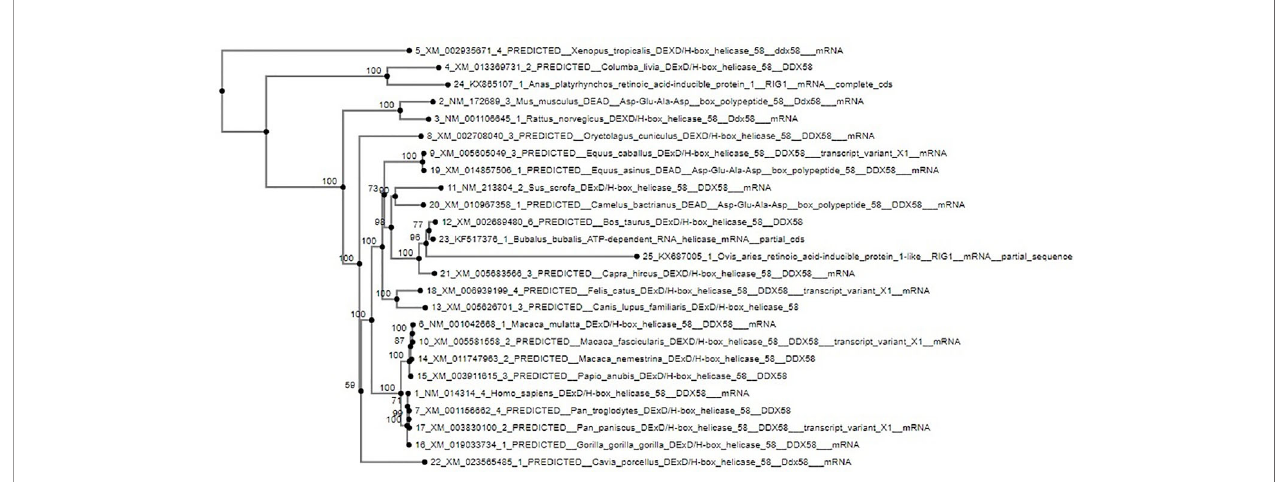
FIGURE 10 | Molecular phylogenetic analysis of sheep with other species based on RIG-I